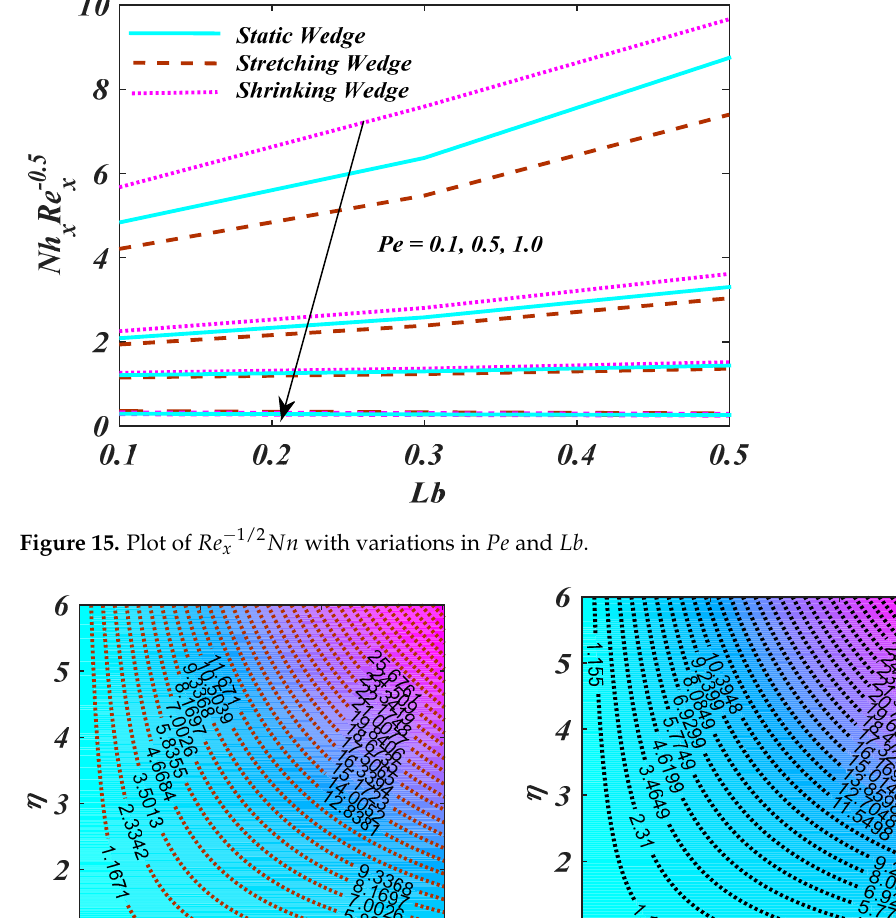
Figure 14. Plot of (cid:1844)(cid:1857) (cid:3051)(cid:2879)(cid:2869)/(cid:2870) (cid:1845)(cid:1860) with variations in (cid:2010) (cid:1853)(cid:1866)(cid:1856) (cid:1829)(cid:1860) .